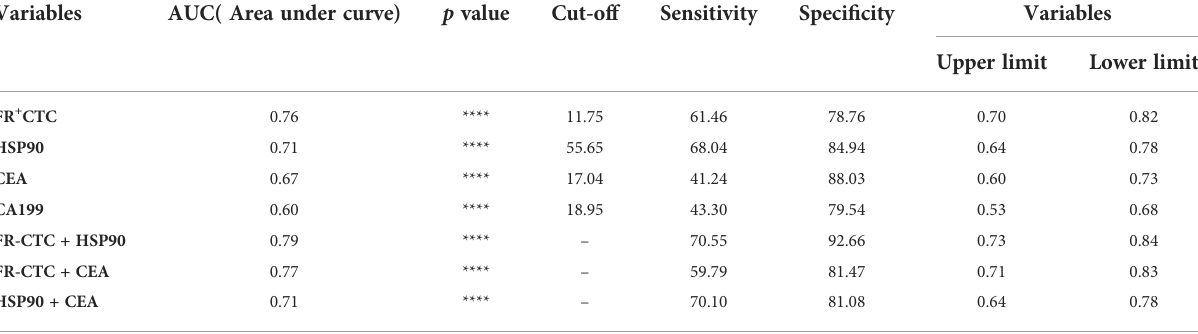
TABLE 2 Diagnostic value of alone and combined biomarkers for distinguishing patients with colorectal cancer liver metastases (LMCRC). Variables AUC( Area under curve) p value Cut-off Sensitivity Speci fi city Variables